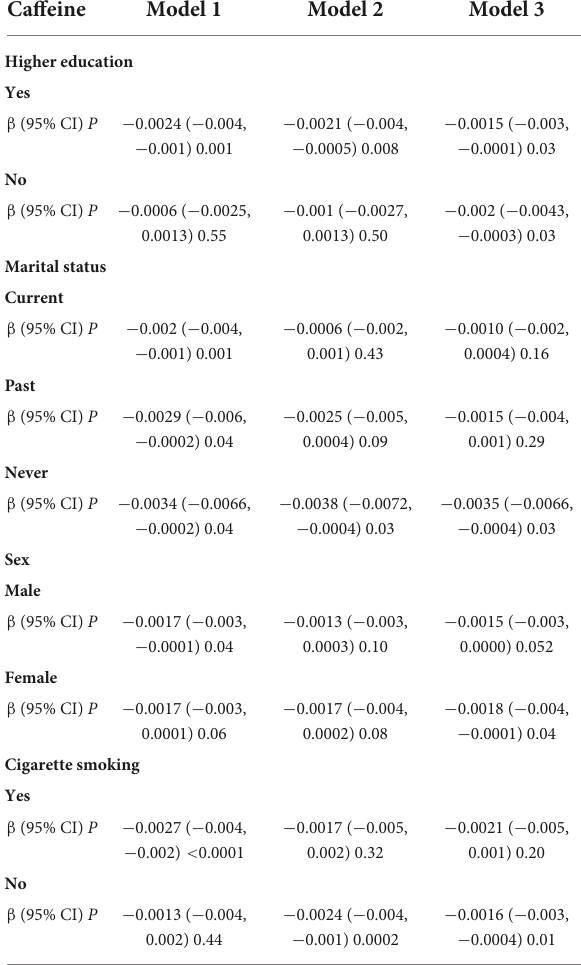
TABLE 4 Association between caffeine intake and depression, stratified by higher education, sex, marital status, and cigarette